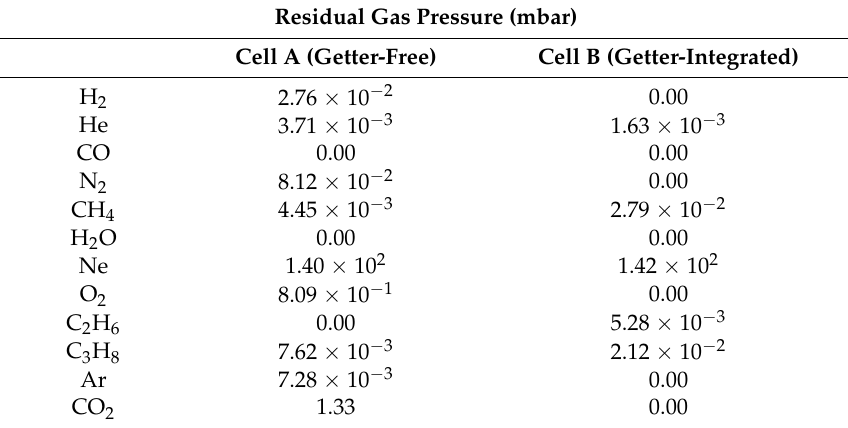
Table 1. The effect of getter film on vacuum in the chamber. Cell A was the sample without getter and Cell B was